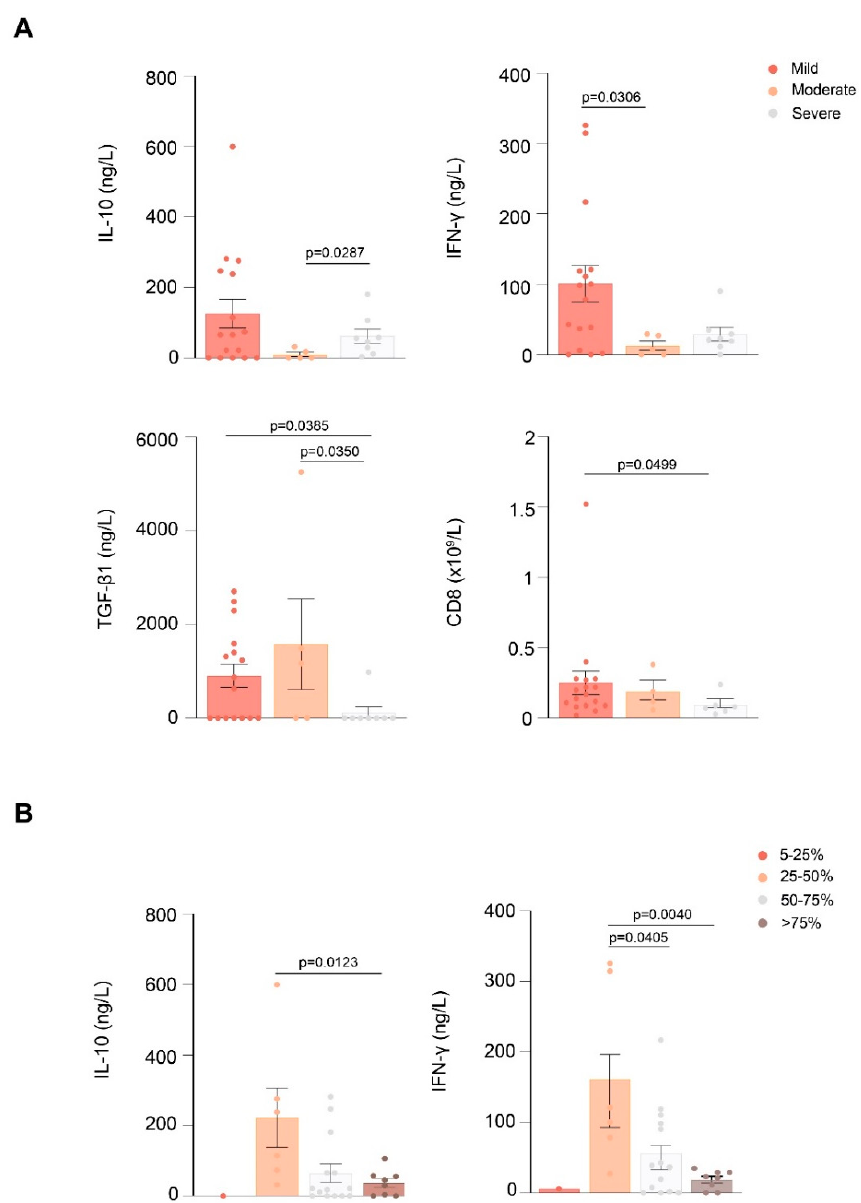
Figure 3. Baseline values of variables showing statistically significant differences between patients with COVID-19 pneumonia according to their SaFI ( A ) or their percentage of lung parenchymal infiltrates ( B ). Abbreviations: CD, cluster of differentiation; IFN- γ , interferon γ ; IL, interleukin; TGF- β 1, transforming growth factor beta 1.